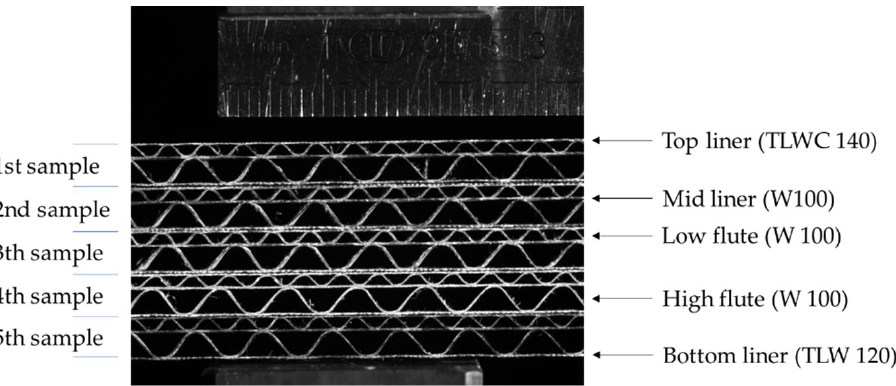
Figure 1. Visualization of 5 samples (stacked on top of each other) of the analyzed corrugated cardboard.